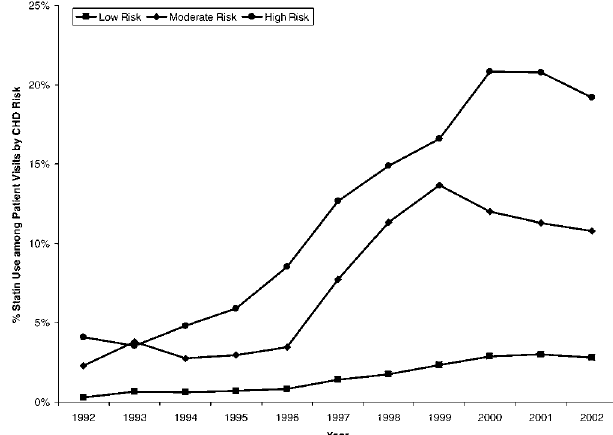
Figure 3. Use of Statins among United States Ambulatory Visits, by CHD Risk